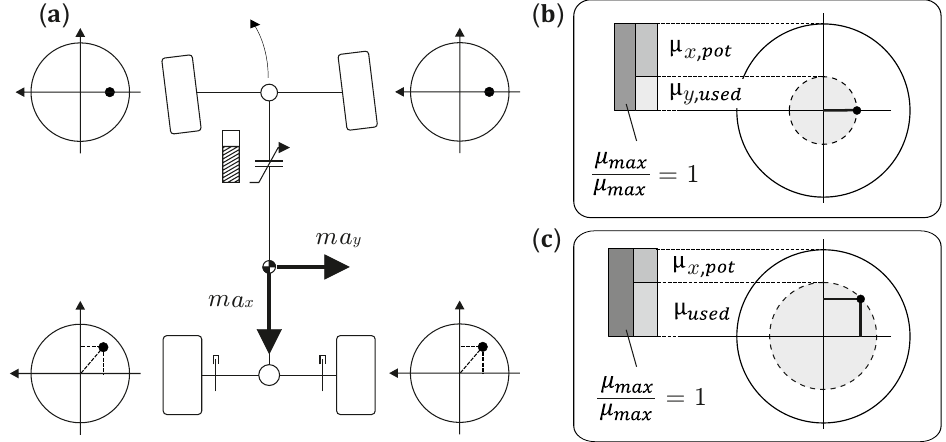
Figure 3. Used friction potential at PON-maneuver: ( a ) Schematic representation on the quasi-static twin-track model. ( b ) Used friction potential µ used and remaining friction potential µ pot on the outside wheel of the front axle and ( c ) on the outside wheel of the rear